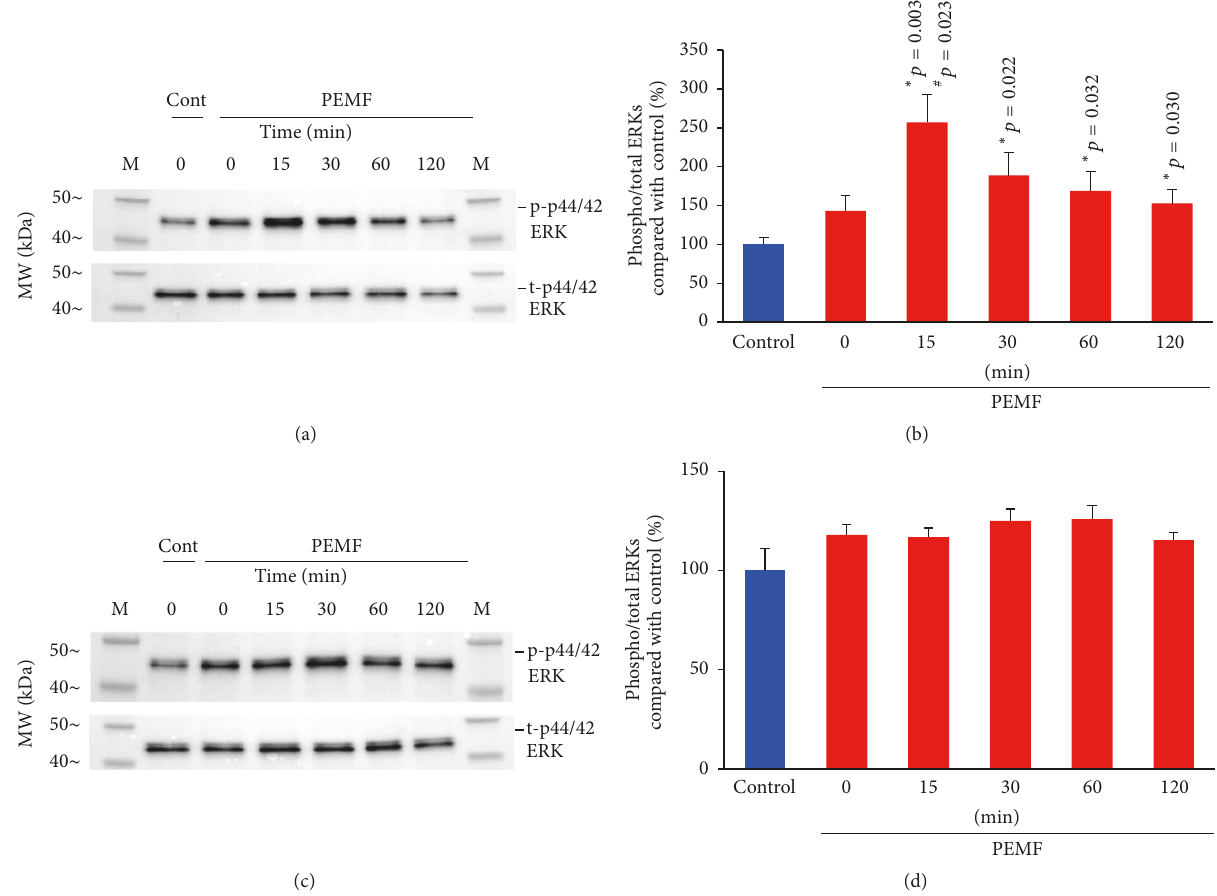
Figure 2: Effect of PEMF on ERK activation. Human BMSCs from two different 24-year-old women and a 27-year-old woman were subjected to 4 h daily PEMF treatment for either 4 days or 9 days. On the 5th (a) or 10th day (c), their cells were treated with PEMF for different time periods as indicated and whole cell lysates were obtained and subjected to Western blot analyses; cells from a 24-year-old woman are shown as an example. ((b) day 5, (d) day 10) The quantitation of activated or phosphorylated ERKs for cells from 2 separate 24-year-old women and a 27-year-old woman was determined by normalization of phosphorylated ERKs to total ERKs after normalization to Cdk2 as a loading control and expressed as a percent of untreated control cells. The results are shown for the cells of the 3 individuals. ∗ indicates significant increase compared to control. # indicates significant increase compared to 0 times of PEMF on the 5th day. The p value ≤ 0.05 is considered as significant using one-way